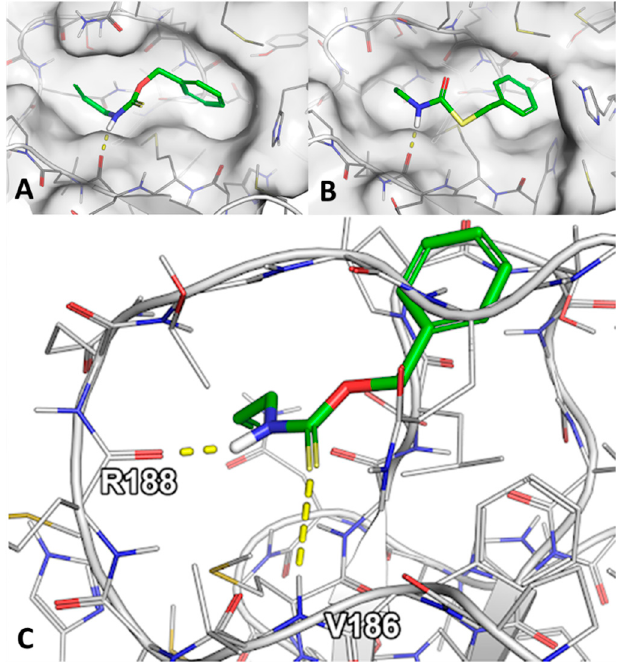
Figure 5. The comparison of the binding of the C4 and C5 compounds. ( A ) The best pose of the C4 compound (Glide docking). ( B ) The best pose of the C5 compound (Glide docking). ( C ) The last frame from the MD simulations of the Mpro protein with bound C4 compound showing an additional hydrogen bond. In case of the C5 compound, the ligand has left the binding site spontaneously.